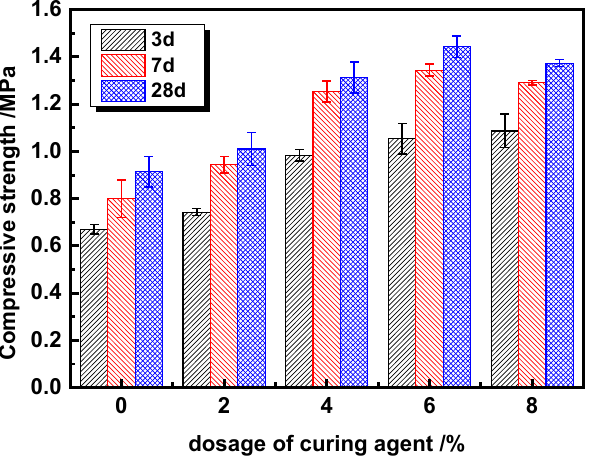
Figure 3. Effect of dosage of the flexible curing agent on compressive strength of stabilized silt with curing ages.